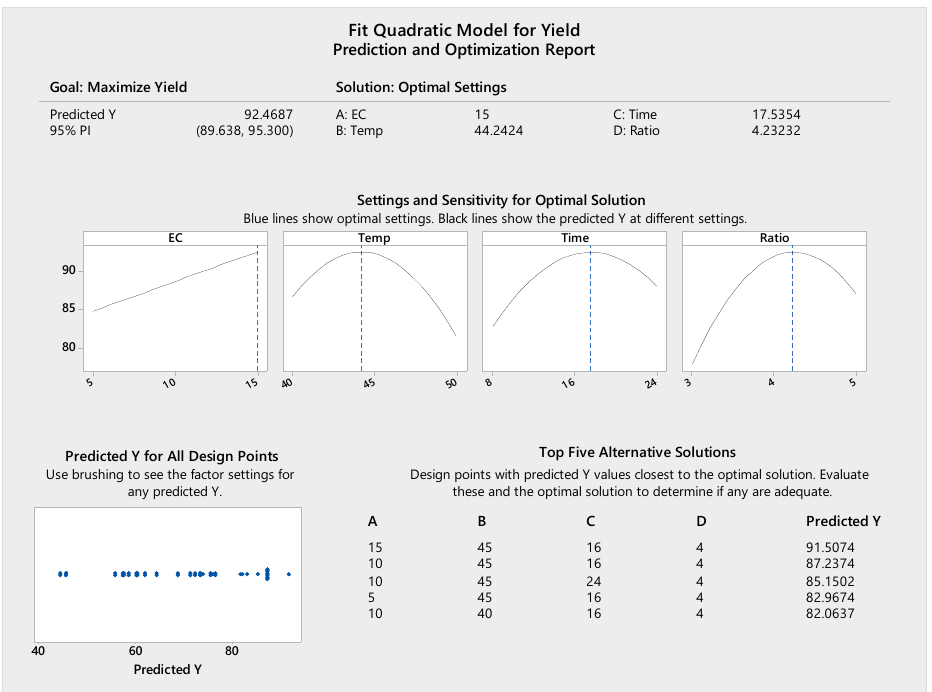
Fit Quadratic Model for Yield Prediction and Optimization Report